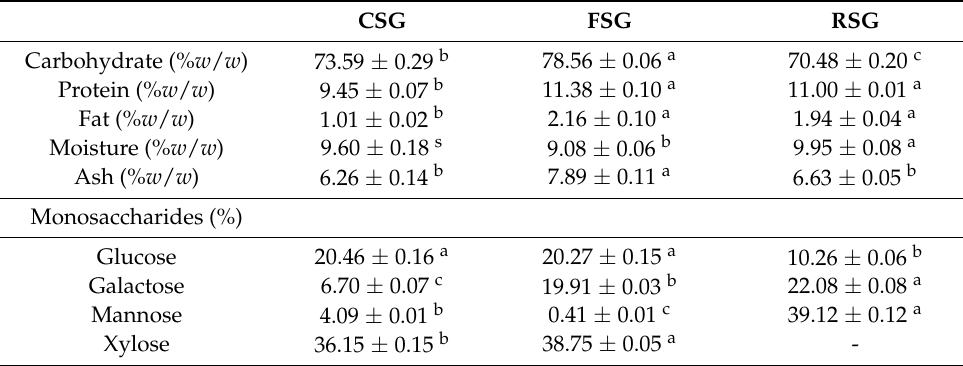
Table 1. Physicochemical properties of